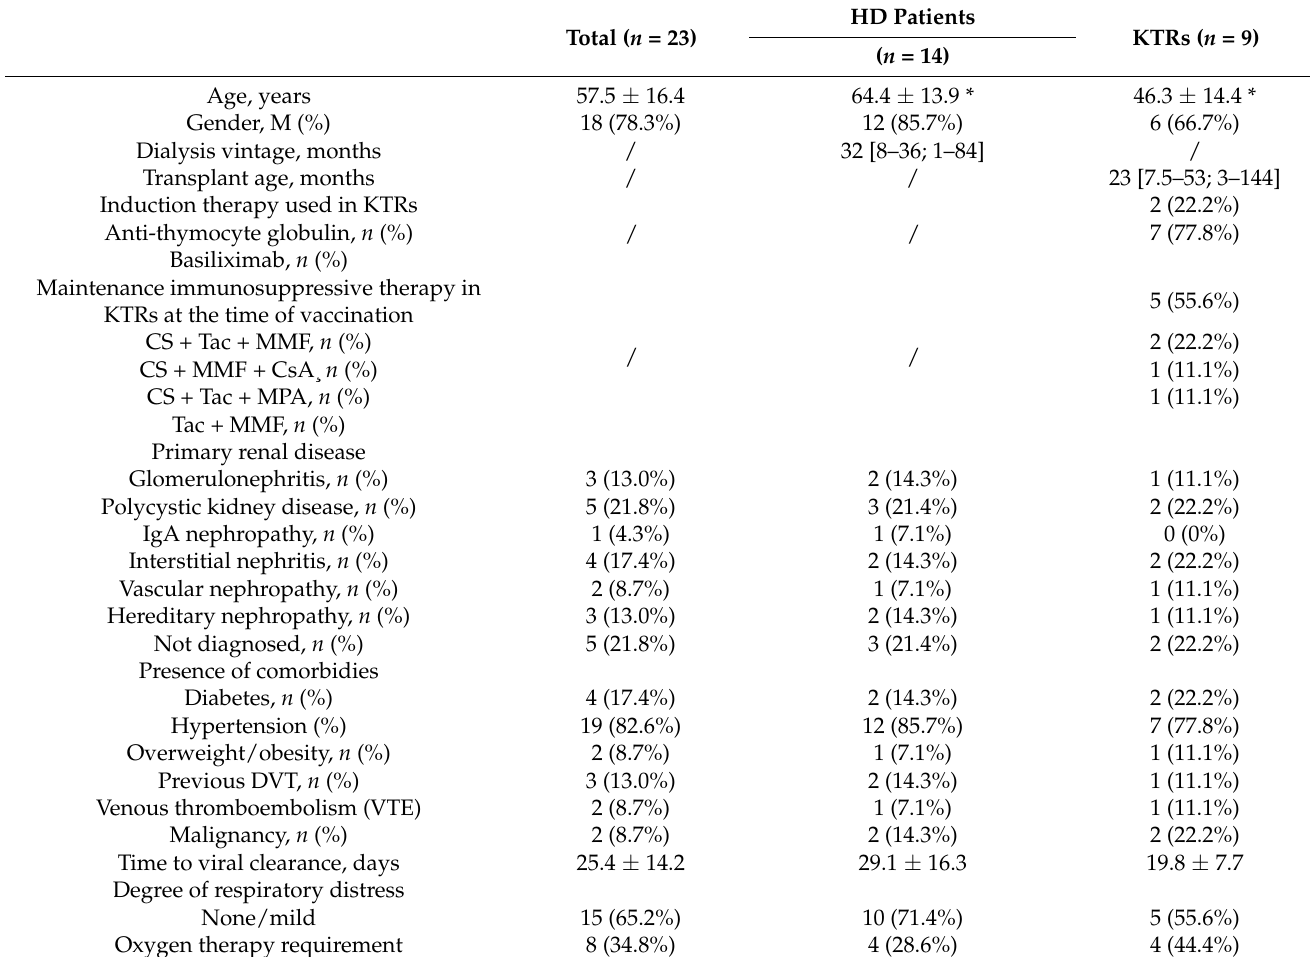
Table 1. Main demographic, clinical, hematology, and COVID-related features in the whole cohort in HD patients and KTRs. Continuous variables are given as means ± SD if normally distributed, or as median with IQR and range (in square brackets) if non-normally distributed. Categorical variables are presented as absolute numbers and percentages (in brackets). * p <